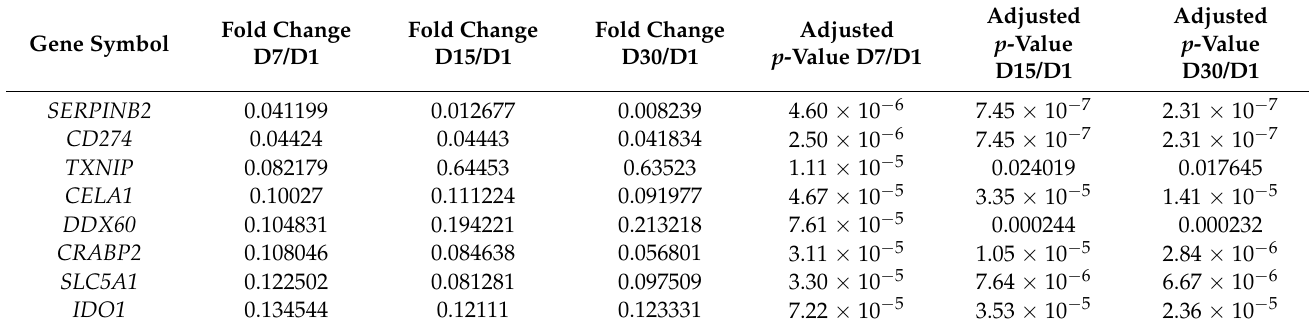
Table 1. Gene symbols, fold changes in expression, Entrez gene IDs and corrected p values of studied genes. Fold Gene Symbol